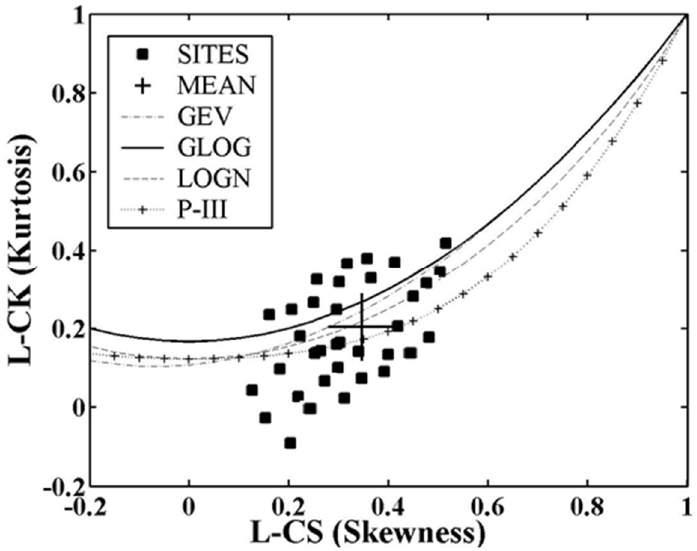
Figure 3. Diagram of linear moments L−CV, L−CS of the studied stations, along with those ex- pected from different candidate probability distributions.